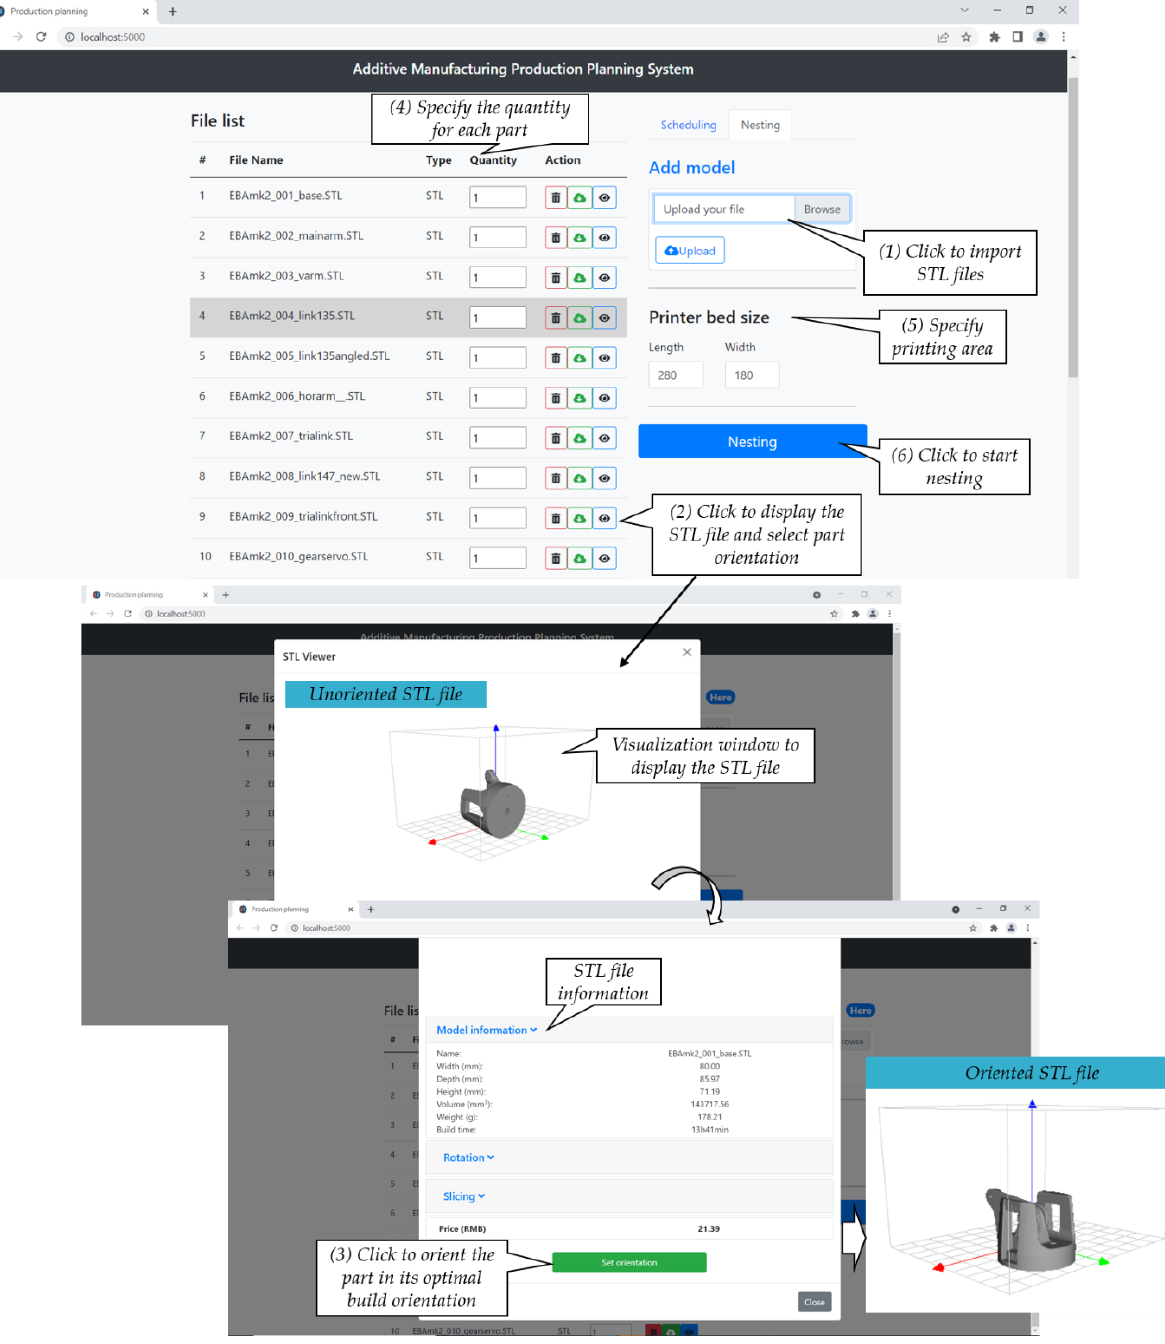
Figure 6. A snapshot of the web app operation.